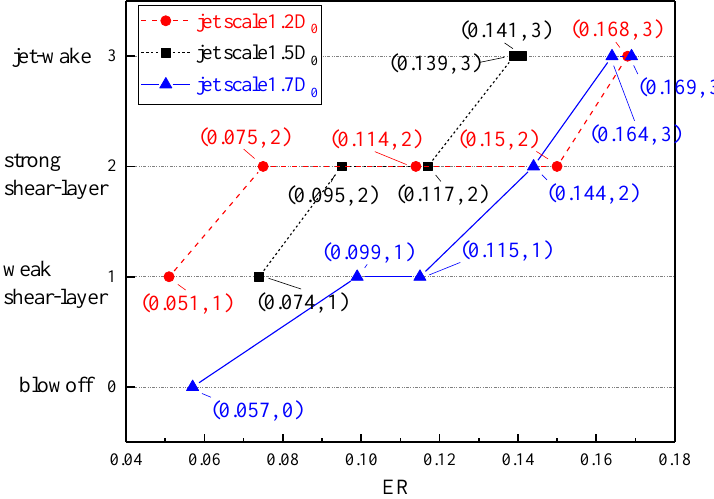
Figure 20. Flame stabilization mode for different jet scales at different equivalence ratios.